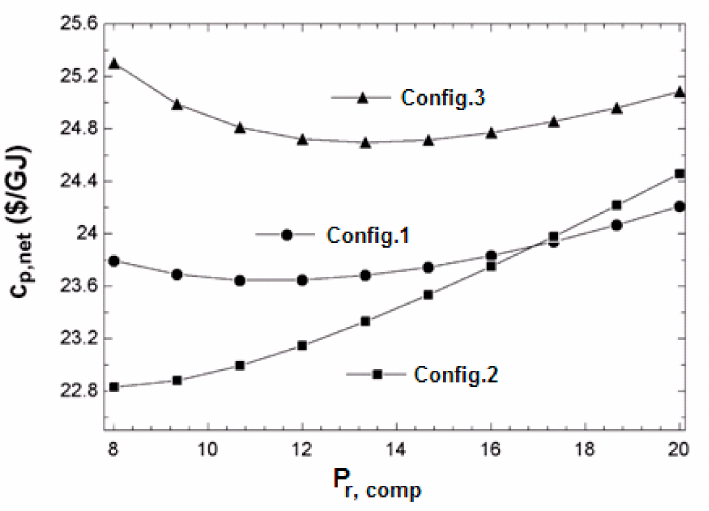
Figure 8. Effect of compressor pressure ratio change on the exergy unit cost of produced